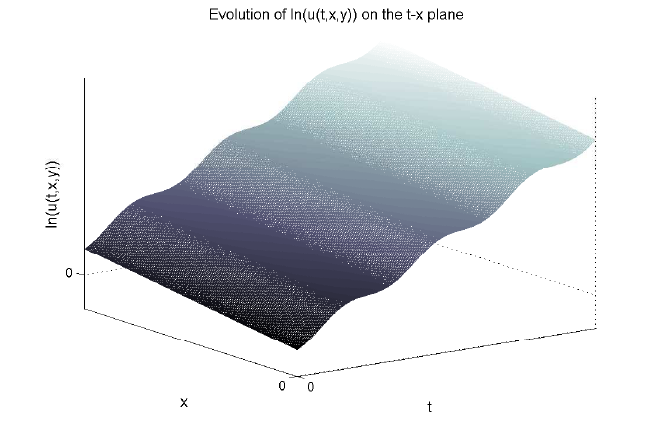
Figure 1. Qualitative evolution of the solution u ( t , x , y ) for the nonautonomous two-dimensional Black-Scholes-Merton Equation (34) in the “t-x” plane, when σ 1 , σ 2 , ρ are constants and r ( t ) = r 0 + ε sin ( ω t )